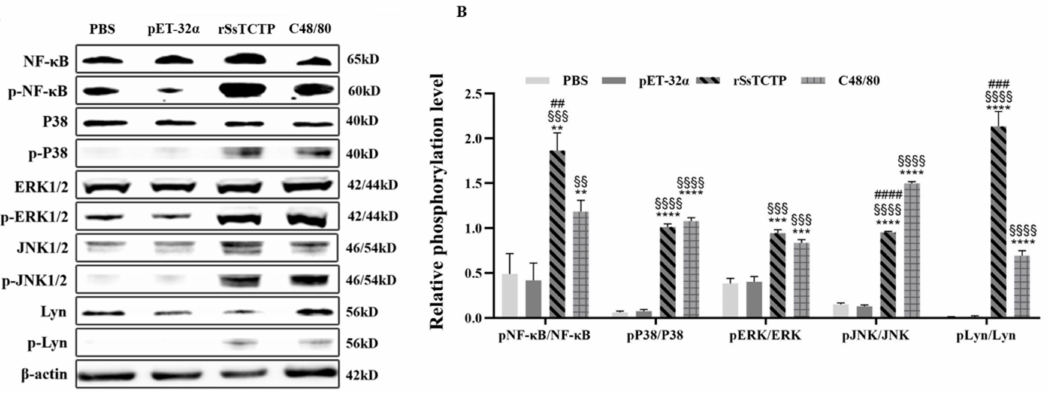
Figure 5. Protein levels of phosphorylated (p) NF- κ B/NF- κ B, pP38/P38, pERK/ERK, pJNK/JNK, and pLyn/Lyn in KU812 cell degranulation. ( A ) Representative Western blotting of three individual experiments. ( B ) The graph of the quantified band density. Data are shown as the means ± the standard deviation (SD) of three Western blotting analyses. ** p < 0.01, *** p < 0.001, **** p < 0.0001 versus PBS group; §§ p < 0.01, §§§ p < 0.001, §§§§ p < 0.0001 versus pET-32 α group; ## p < 0.01, ### p < 0.001, #### p < 0.0001 versus C48/80 group ( t -test). NF- κ B, nuclear factor kappa B; p38, mitogen-activated protein kinase 14 (MAPK14); ERK, extracellular regulated kinase; JNK, JUN N-terminal kinase; Lyn, LYN proto-oncogene, Src Family tyrosine kinase. rSsTCTP, recombinant Sarcoptes scabiei translationally controlled tumor